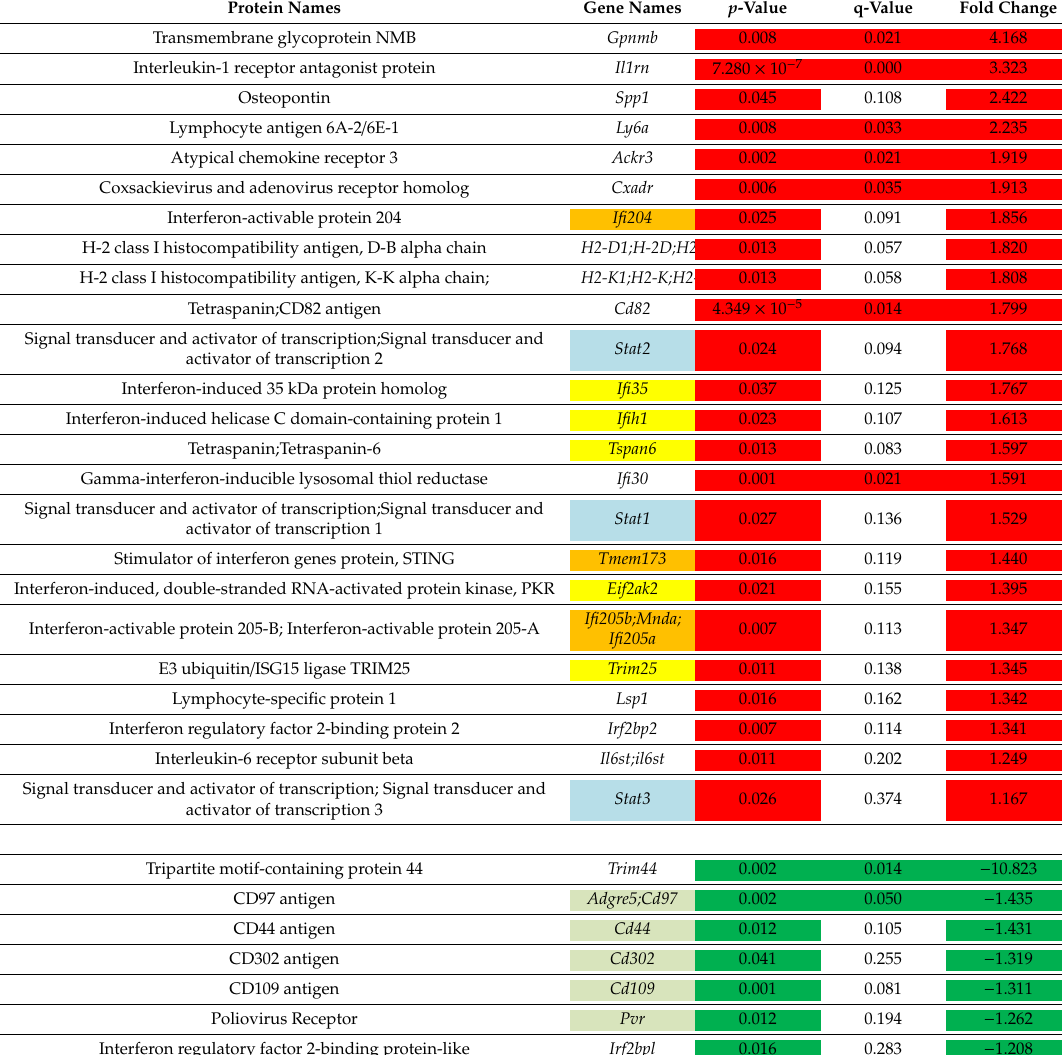
Table 3. List of dysregulated factors in the innate immune system, ordered by direction of change (red for upregulations, dark green for downregulations) and by fold-changes. Among the many existing receptors for damage-associated-patterns, components of the pathways for detection of toxic DNA (highlighted by orange color) and double-stranded RNA (yellow) with their downstream nuclear transcription factors in the Stat-family (sky blue) were prominent among the upregulations. Plasma membrane epitopes (light green color) within the cluster of di ff erentiation CD* superfamily stood out among the